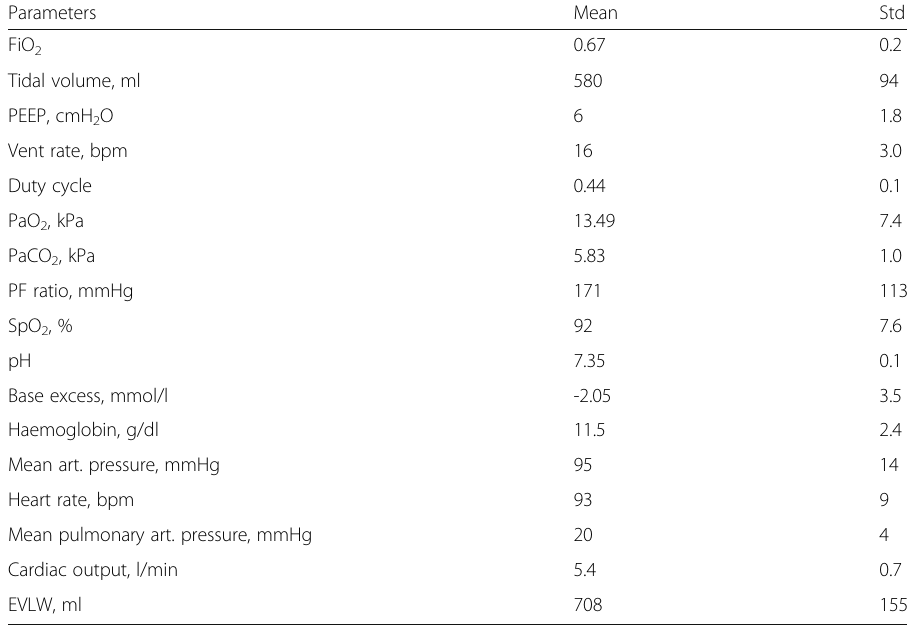
Table 1 Baseline characteristics of patients Parameters Mean